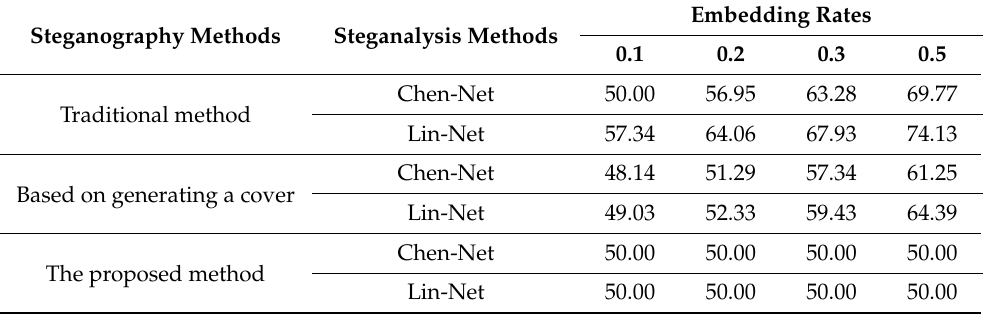
Table 5. The accuracy of steganalysis detection with the different steganography algorithms under different embedding